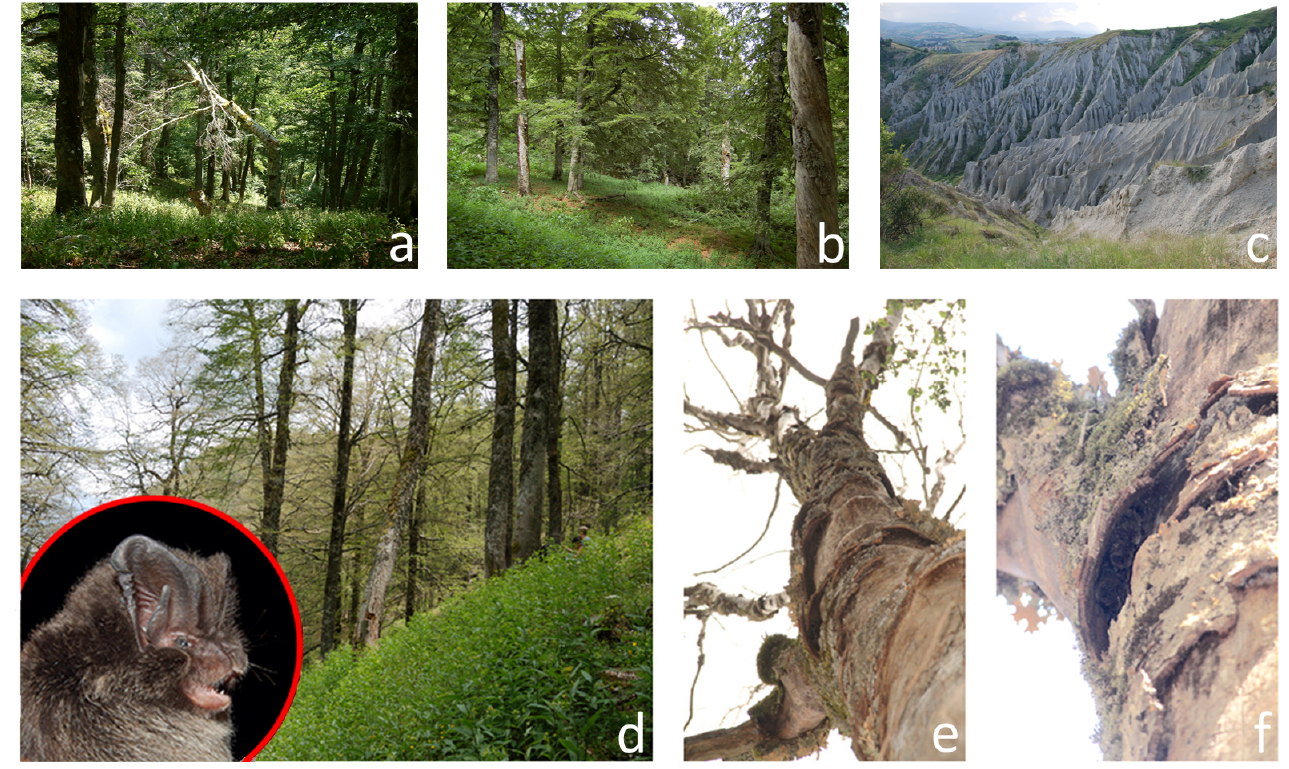
Figure 3. Barbastelle bats ( Barbastella barbastellus ), often deemed forest bats typically associated with unmanaged forest ( a ), may in fact occur in logged sites ( b ) or even in clay badlands ( c ) characterised by few or no trees. The species is sensitive to multiple spatial scales, from landscape/habitat ( d ) to tree ( e ) and cavity ( f ) types. In ( f ), a small reproductive group can be noticed roosting underneath the flaking bark of a beech snag.